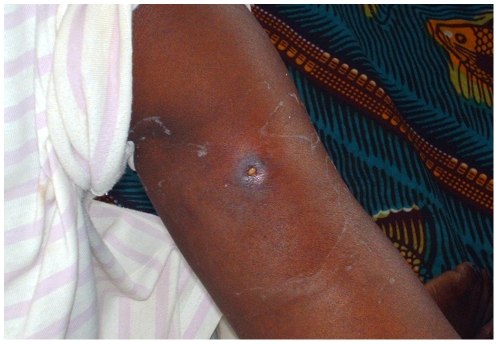
Single ulcerative lesion <5 cm diameter (confirmed by IS2404-PCR).